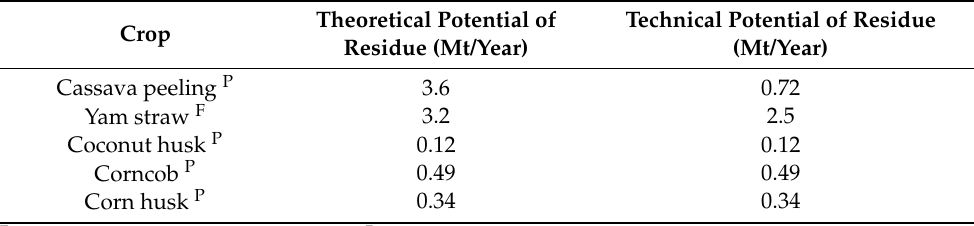
Table 1. Potential of crop residues in